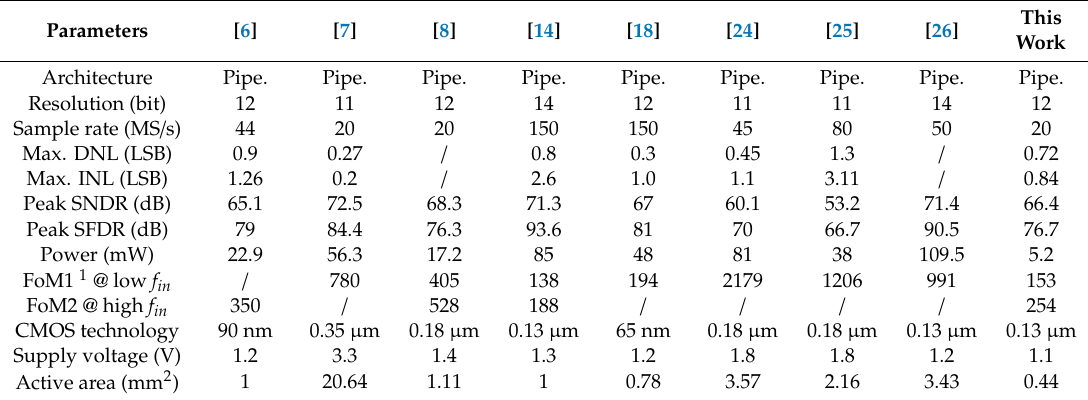
Table 2. Performance summary and